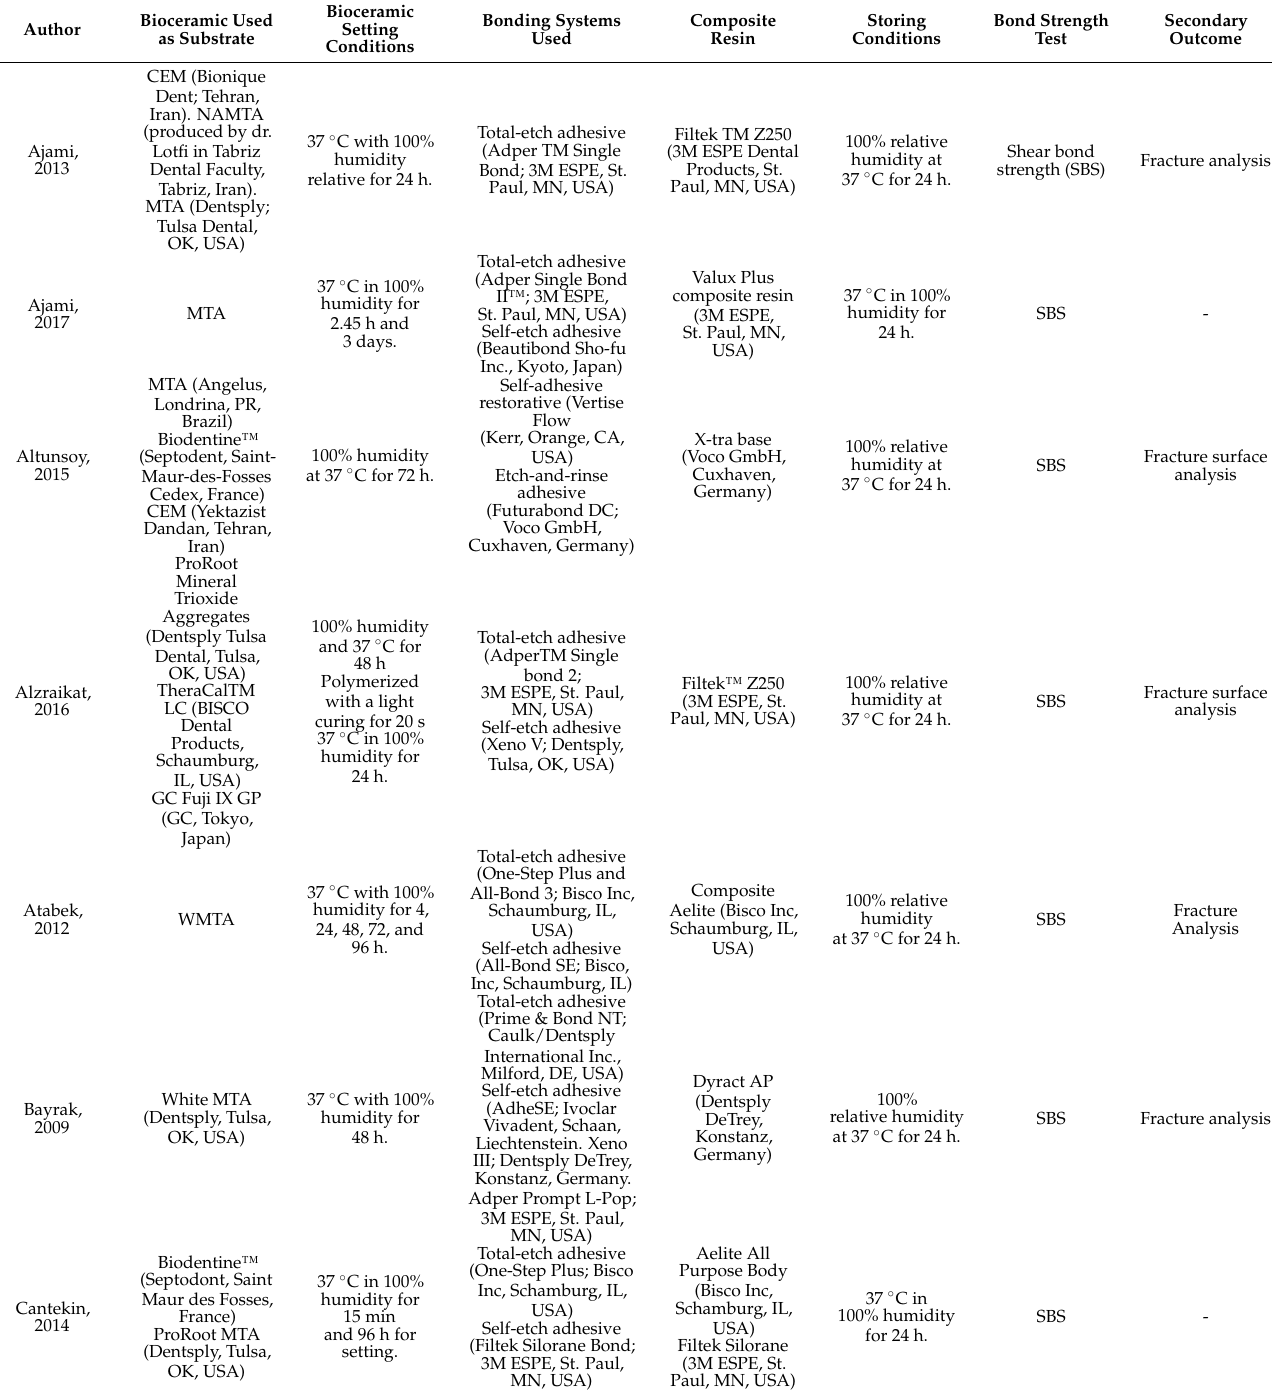
Table 1. Demographic